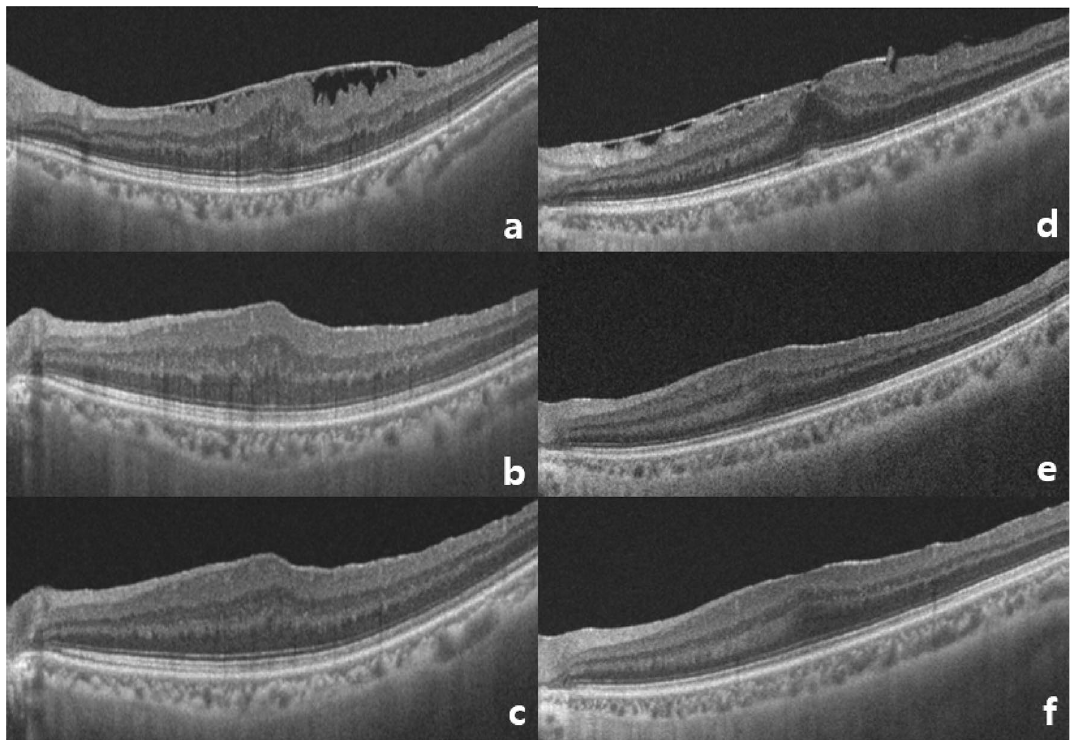
Figure 3. Optical coherence tomography (OCT) B-scans taken from patients with epiretinal membrane (ERM), one from a 77-year-old male who had phaco + ppV (a. baseline CVI = 60.92%, b. 3 months post-op CVI = 61.12%, c. 6 months post-op CVI = 59.40%) and another from a 56-year-old female who had ppV (a. baseline CVI = 61.08%, b. 3 months post-op CVI = 60.03%, c. 6 months post-op CVI = 60.01%). Choroidal vascularity index in phaco + ppV group increased until 3 months after surgery but dropped to below baseline at 6 months. Choroidal vascularity index in ppV group showed a constant decrease until 6 months after